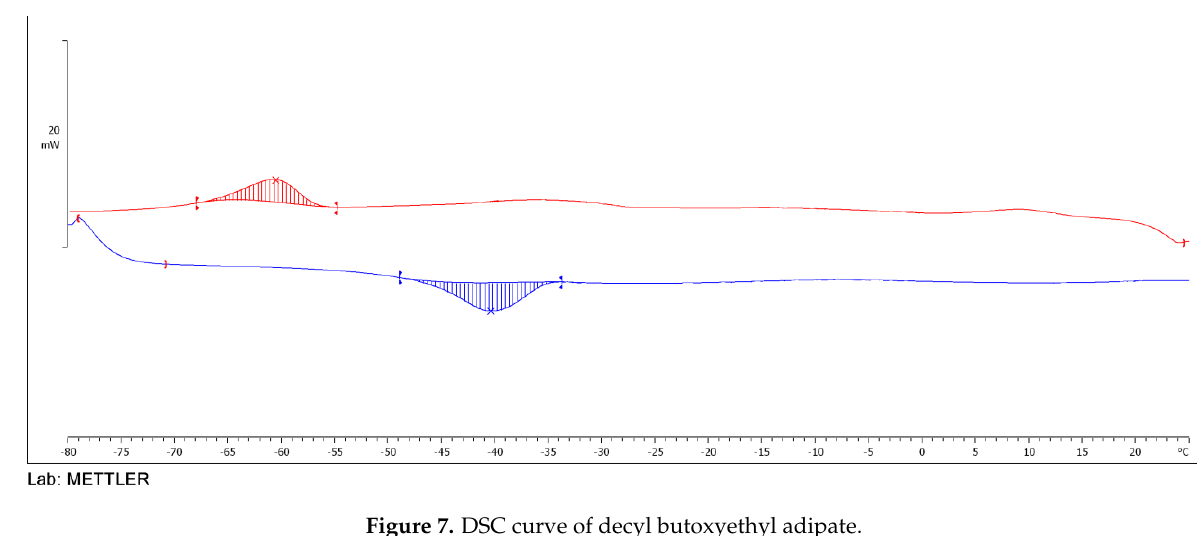
Figure 6. DSC curve of butyl butoxyethyl adipate.